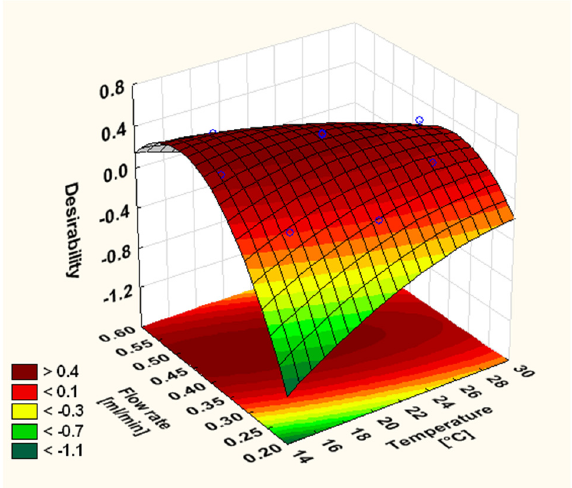
Figure 4. Response surface of Derringer’s desirability estimated from the central composite design as a function of flow rate and temperature.